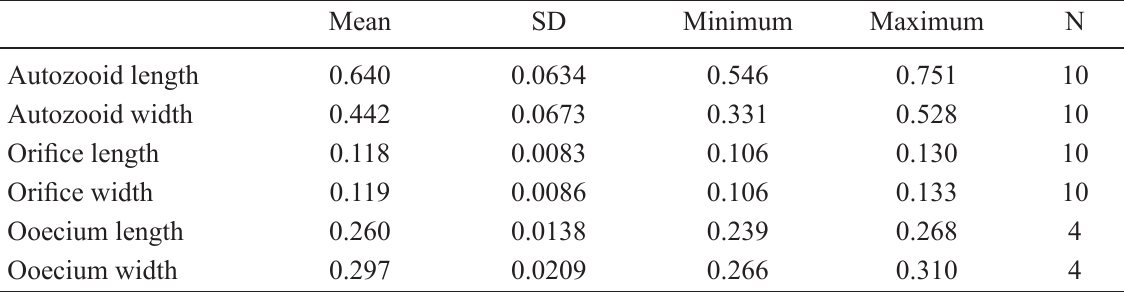
Table 2. Measurements (in mm) of Escherina alderi (Busk, 1856) (lectotype and paralectotypes of Schizoporella ovum Jullien, 1882). SD = standard deviation; N = number of